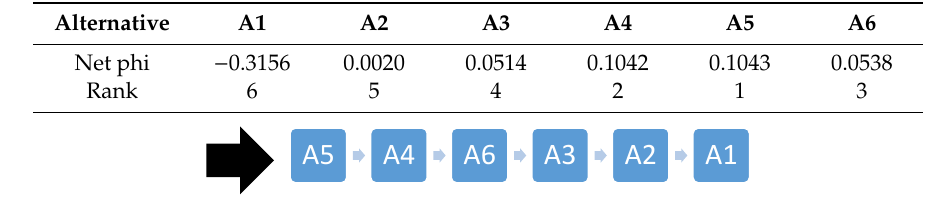
Table 15. Change 1